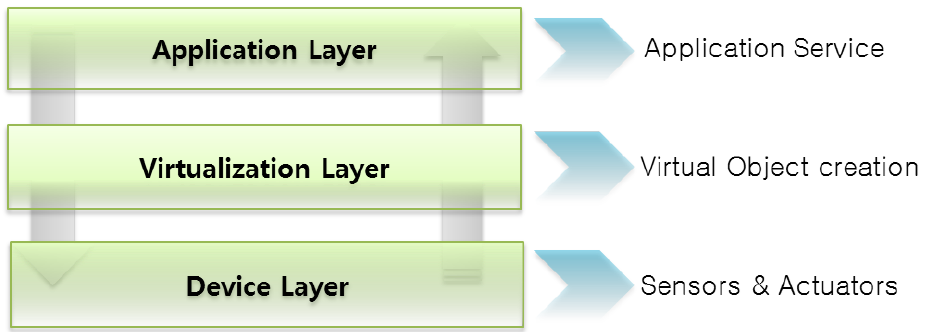
Figure 4. The object virtualization process happens in three layers. After getting the application’s requirement from the application layer, the virtualization layer creates ViOs against physical objects. This layer provides the bridging between the physical world and virtual world. On the other hand, the application layer interfaces with the user, and the device layer consists of all the physical objects and gateways of those